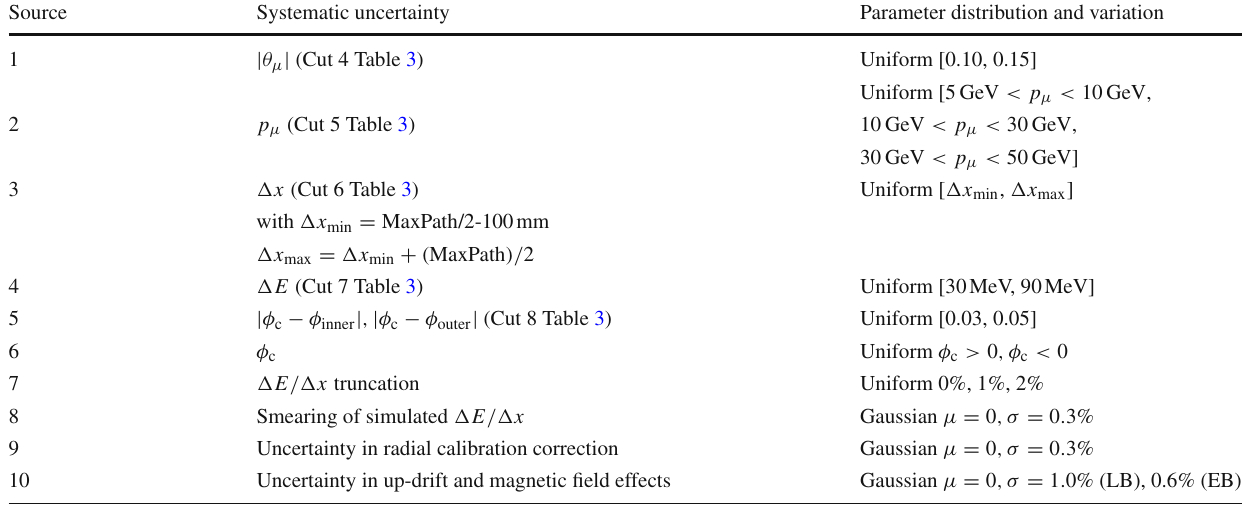
Table 4 Different sources of systematic uncertainty considered in the analysis of the cosmic muons. Sources 1–5 are associated with the event selection procedure, other sources are relevant for the double ratio responses. The distributions of the parameters used in the analysis are